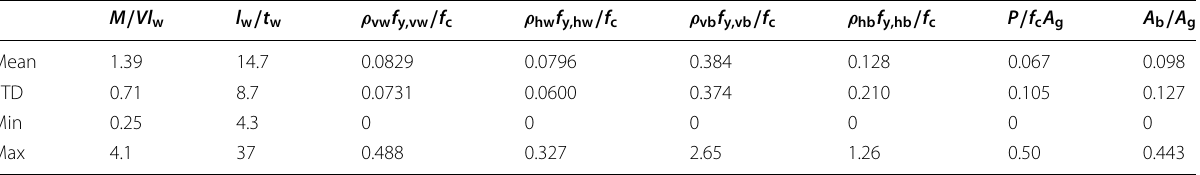
Table 3 Statistical characteristics of the input